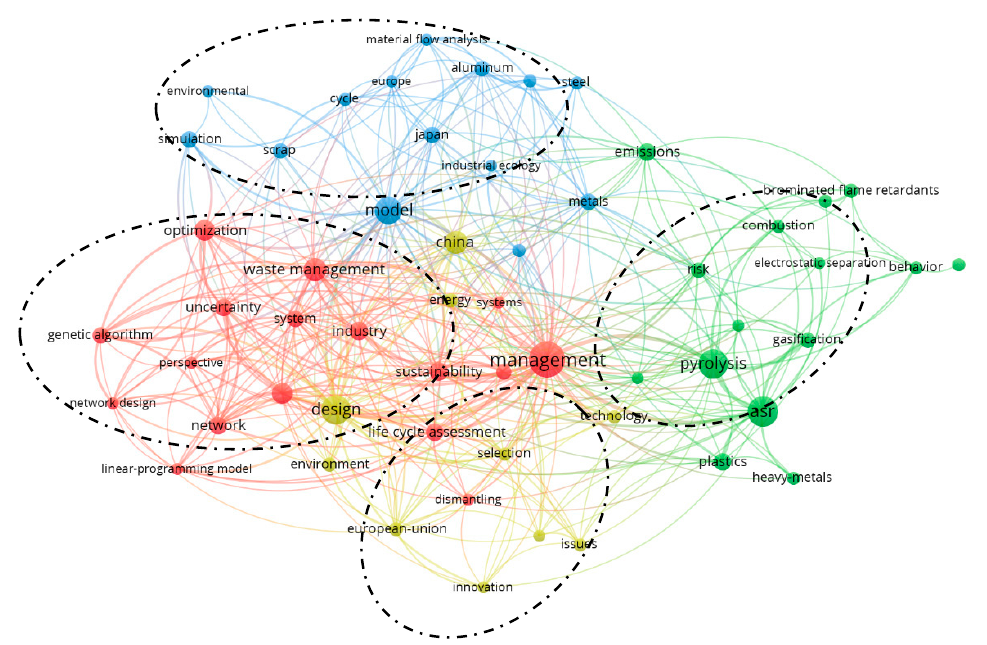
Figure 10. The network visualization map of the 103 most frequently occurring keywords.